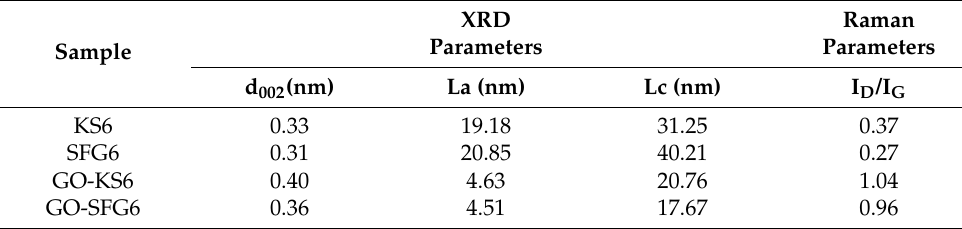
Table 1. The structural parameters of the graphite precursors and the prepared GOs.